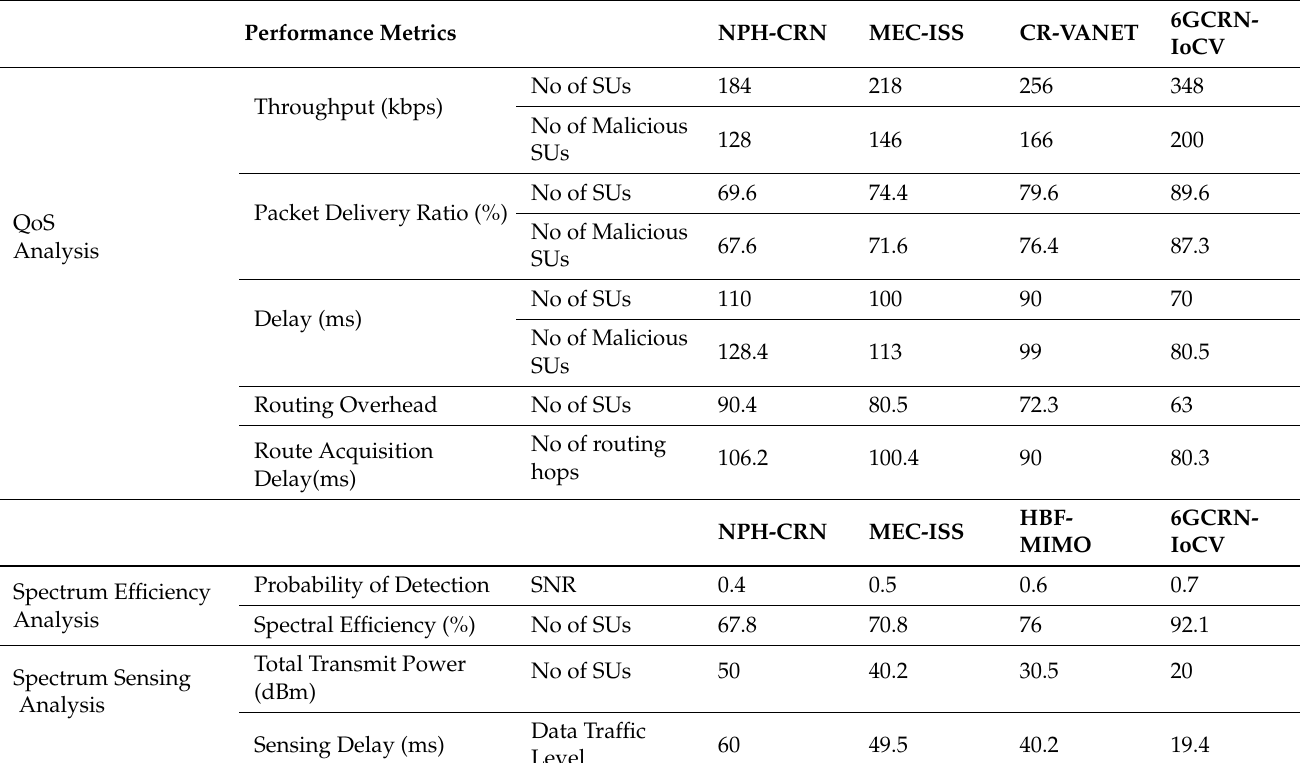
Table 5. Numerical analysis of the poposed vs. existing